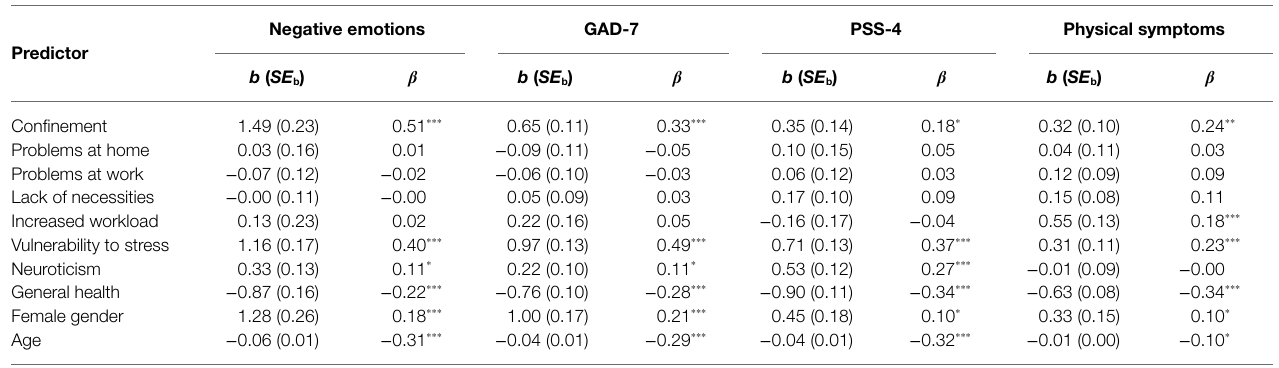
TABLE 4 | Regression coefficients in the structural model for predicting the four mediator variables.